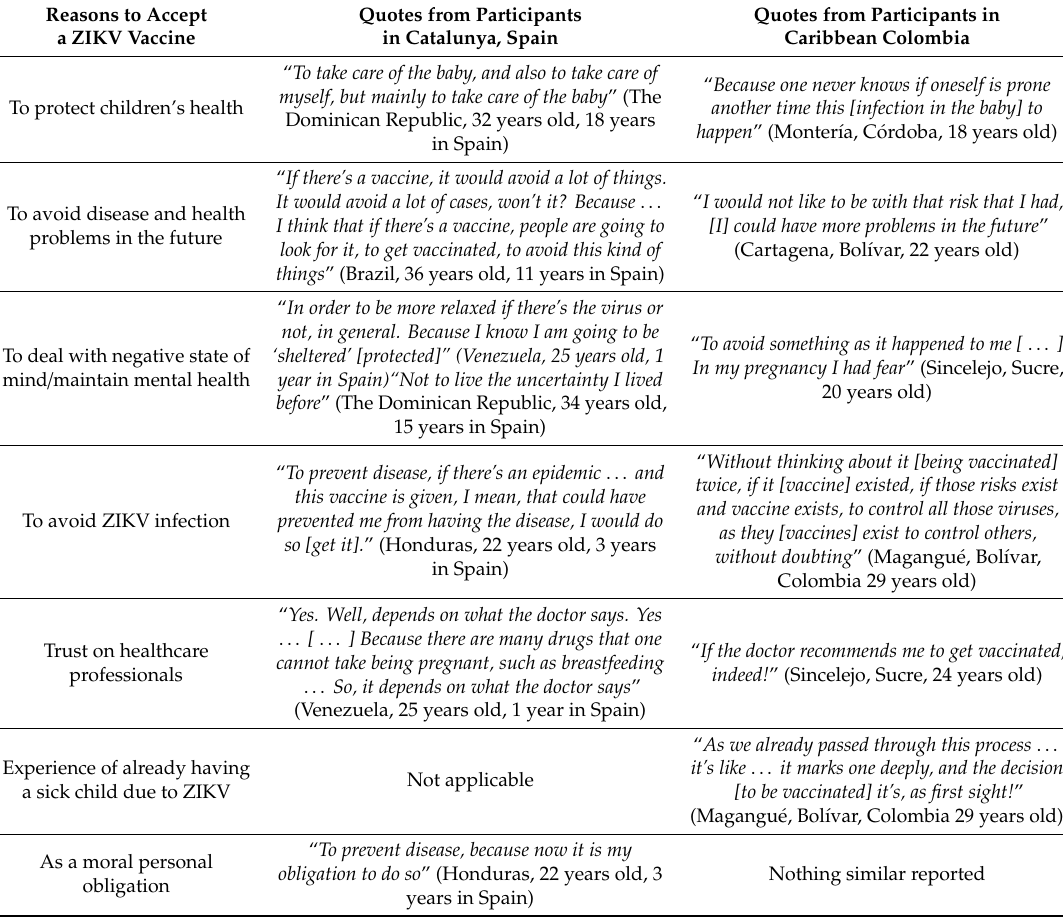
Table 2. Reasons for accepting a hypothetical Zika virus (ZIKV)